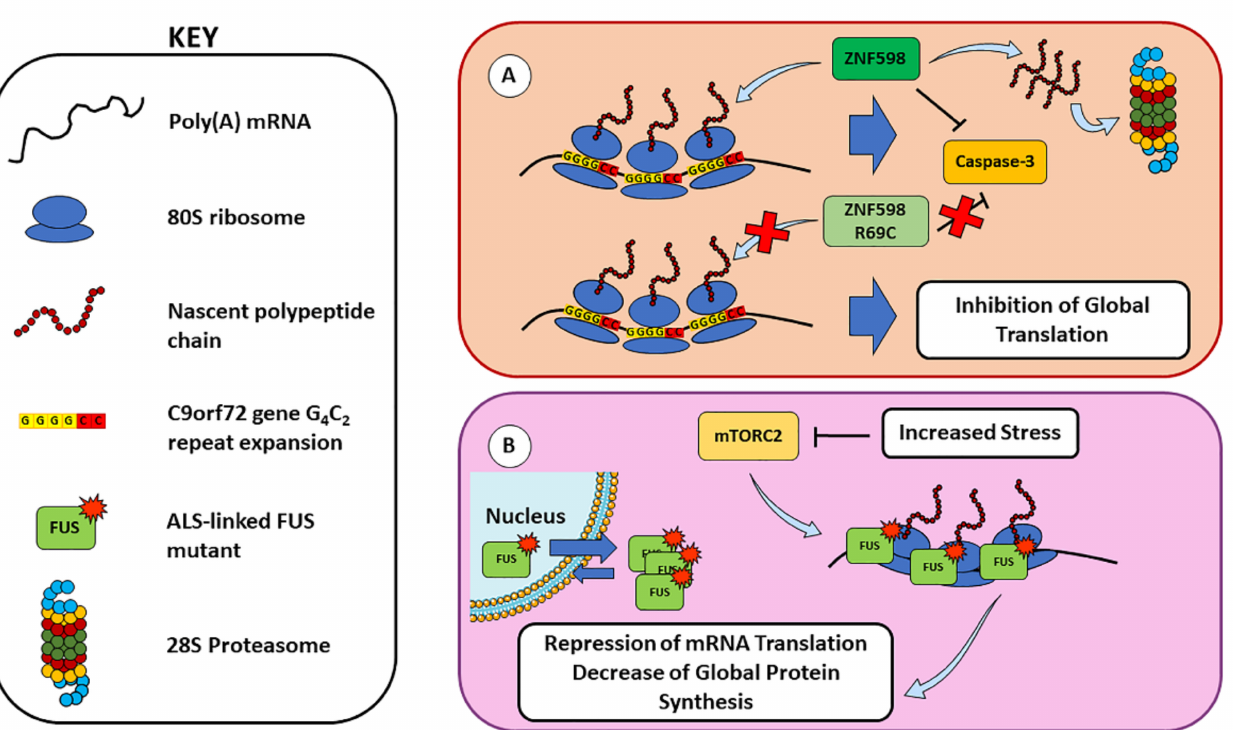
Figure 2. RQC defects in FTD and ALS and their link with ribosome stalling. ( A ) The E3 ubiquitin ligase ZNF598 co-translationally regulates the expression of the peptide chain derived from the G 4 C 2 repeat expansion in C9orf72 gene, by directing the aberrant peptides to the proteasome system and suppressing the caspase-3-mediated apoptotic pathway. However, the ZNF598R69C mutant observed in pathologic conditions showed a loss of these functions, resulting in translation inhibition. ( B ) In an ALS context, pathology-correlated mutants R521G and P525L of FUS have a higher cytoplasmic residency and can highly associate with translating ribosomes [42]. Upon mTORC2 inhibition, enhanced FUS association with polyribosomes results in the inhibition of global translation (see text for